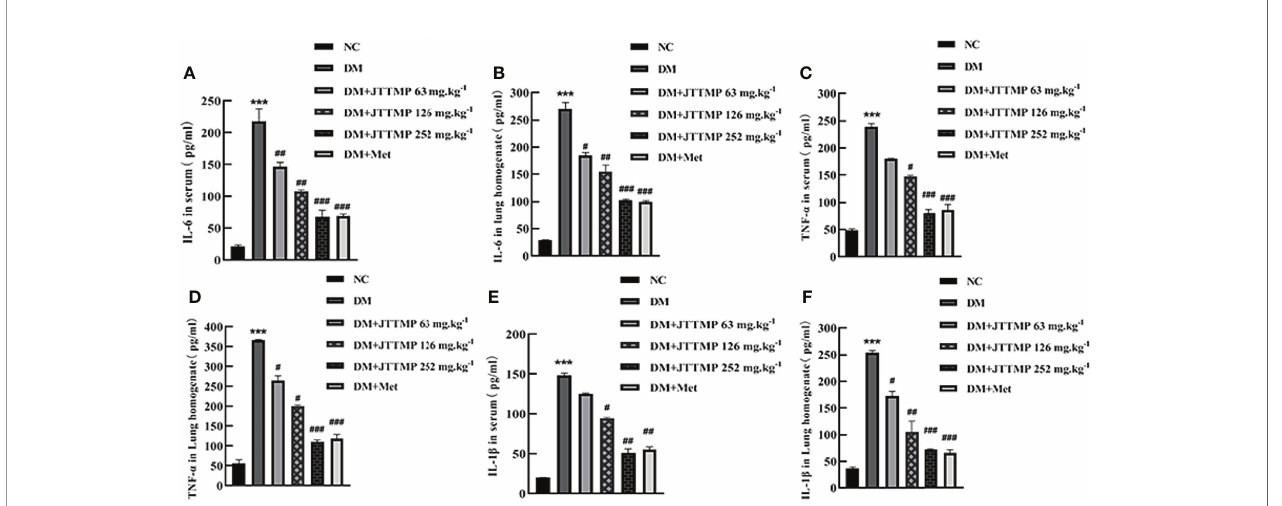
FIGURE 1 | Expression of in fl ammatory factors IL-6, TNF- a , and IL-1 b in serum and lung homogenate of rats from different groups. (A, B) The concentration of IL-6 in serum and lung homogenate of rats from different groups. (C, D) The concentration of TNF- a in serum and lung homogenate of rats from different groups. (E, F) The concentration of IL-1 b in serum and lung homogenate of rats from different groups. vs NC group, ** P <0.001; vs DM group, # P< 0.05, ## P<